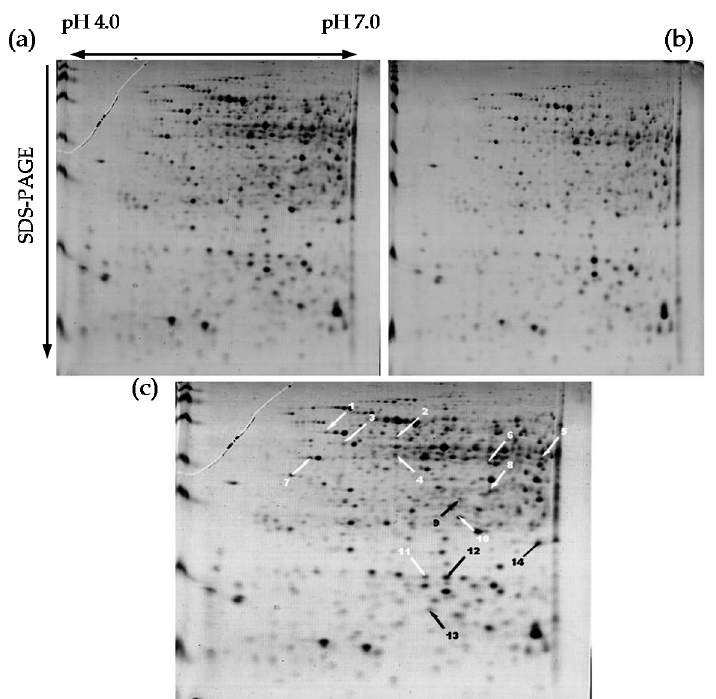
Figure 5. Protein profile of RJS9-2 at two NaCl levels through 2-DE analysis. ( a ) Protein profiles in the 0.0017 M NaCl treatment; ( b ) Protein profiles in the 0.3 M NaCl treatment; ( c ) Picture of two merged 2-DE gels under 0.0017 and 0.3 M NaCl treatments. After bacterial cell proteins were extracted, 80 µg of protein was loaded onto an IPG strip (pH 4–7, 11 cm) and separated by SDS-PAGE. Protein spots showing enhanced and repressed accumulation between the 0.0017 M and 0.3 M NaCl treatments are highlighted with black and white arrows, respectively.